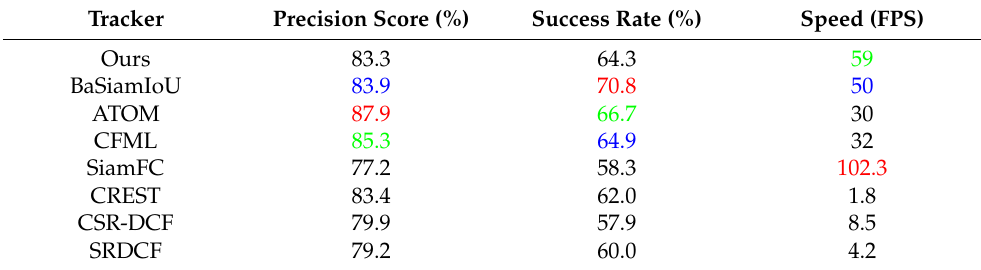
Table 1. The real-time performance of the advanced trackers on the OTB-100 dataset. In the table, red, green and blue indicate the top three scores